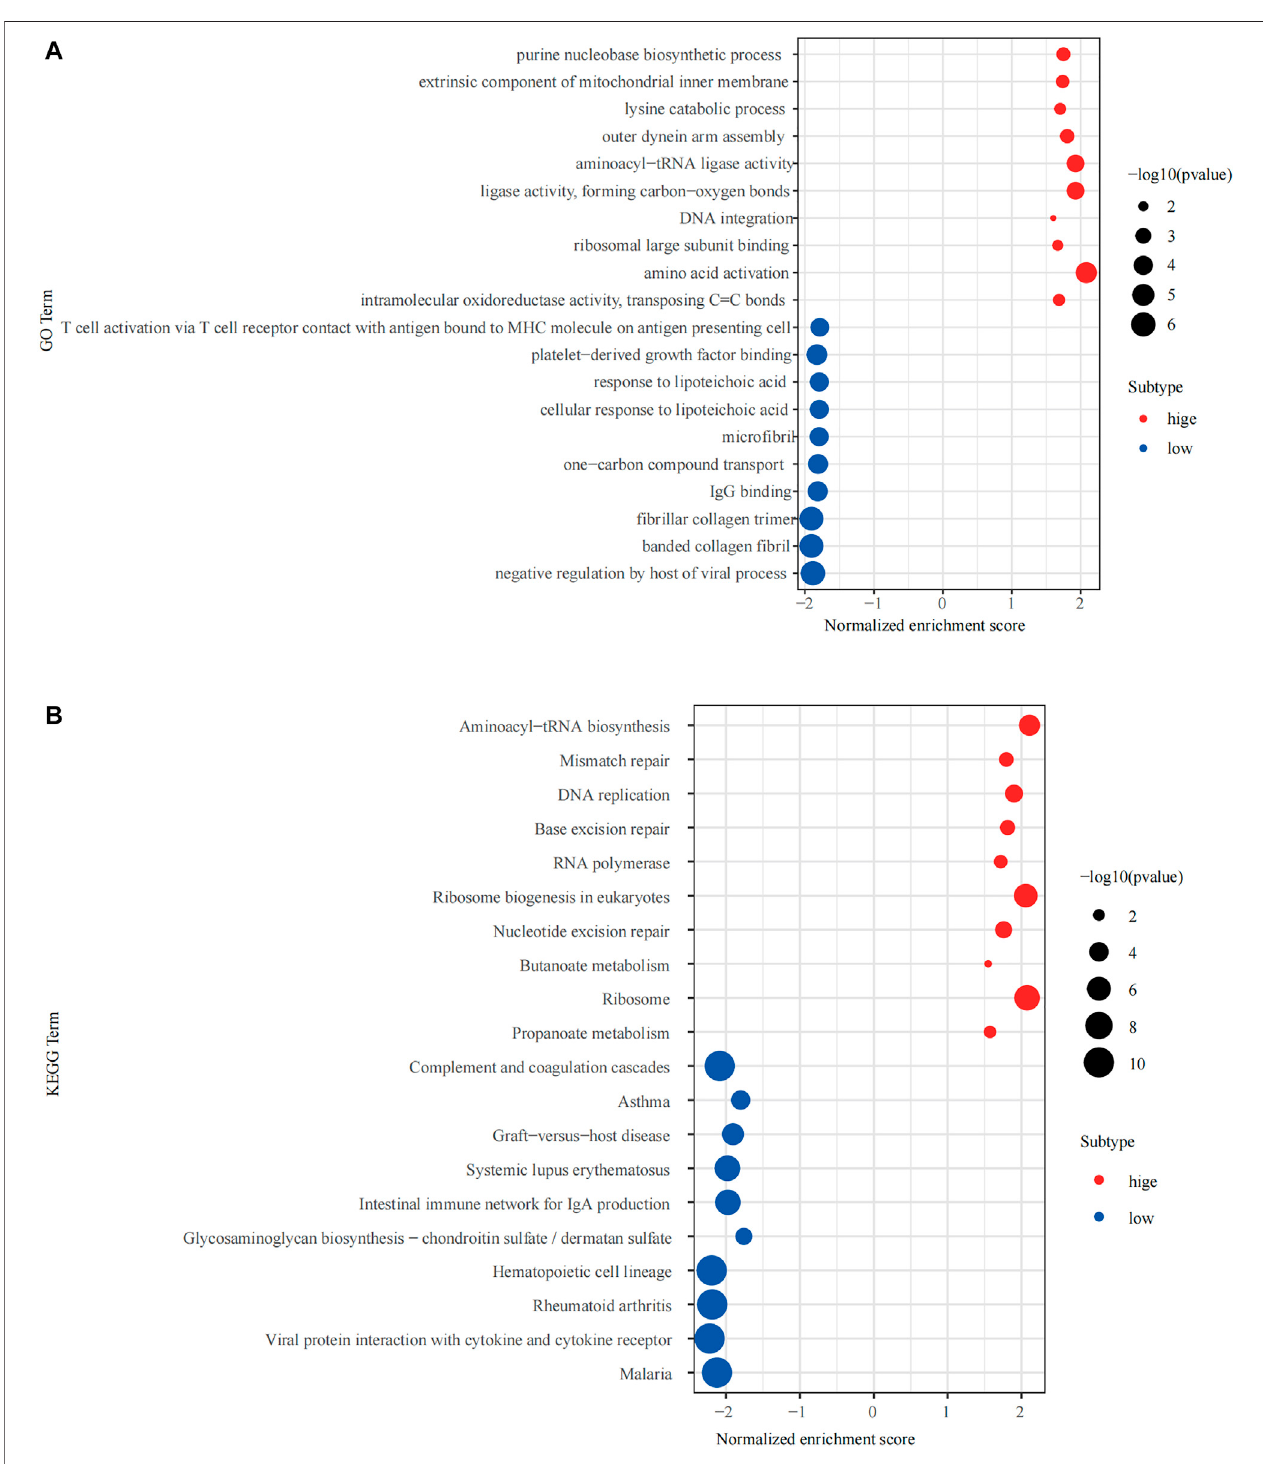
FIGURE 5 | Gene Set Enrichment Analysis (GSEA) of the high and low expressing NPM1 groups. (A) The results of Gene Ontology (GO) enrichment analysis. (B) The results of Kyoto Encyclopedia of Genes and Genomes (KEGG) enrichment analysis.